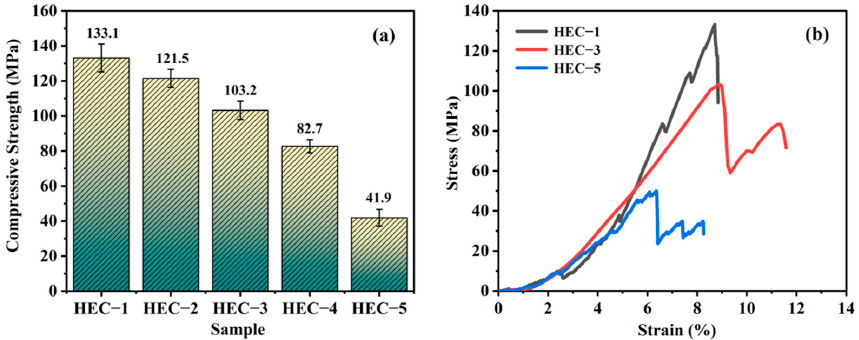
Figure 7. ( a ) Relationship between compressive strength and porosity, and ( b ) typical stress-strain curves of the porous HECs. curves of the porous HECs.